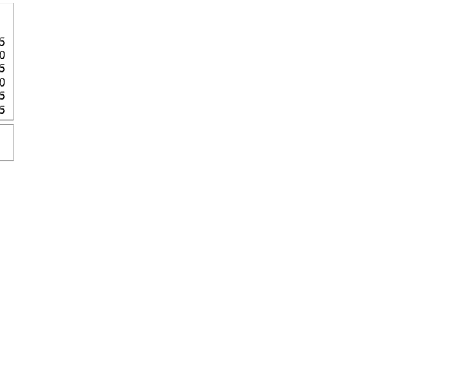
Figure 3. Contour Plot of: ( a ) Friction Coefficient vs. Temperature and Speed for a Hold Value of Pressure of 25 MPa; ( b ) Friction Coefficient vs. Pressure and Speed for a Hold Value of Temperature of 560 °C.